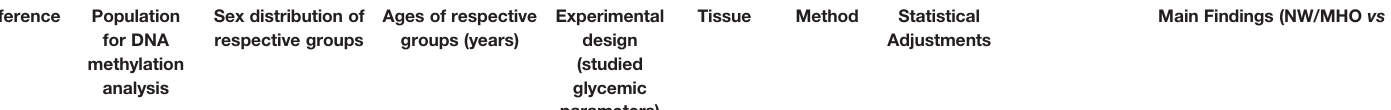
TABLE 2 | Data obtained from epigenome-wide studies assessing DNA methylation in dysglycemic states or correlated with glycemic